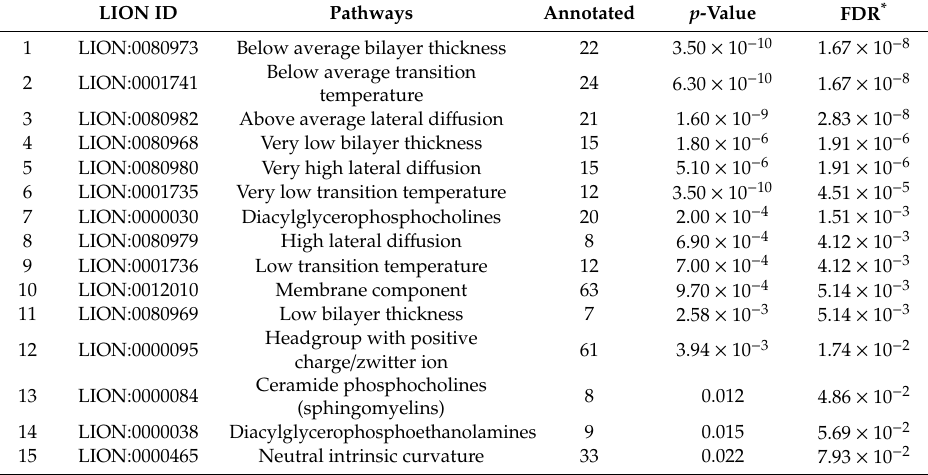
Figure 4. Differential expression of lipids between AGS-EBV and AGS. ( a ) Two-dimensional score plot derived from the lipid profile based on the untargeted UPLC-QToF MS method showed marked differences between the AGS-EBV and AGS cell lines. ( b ) The heatmap showed distinguishable contrast regarding the expression of lipids. Table 1. The lipid metabolic pathways derived from lipids significantly altered by EBV.